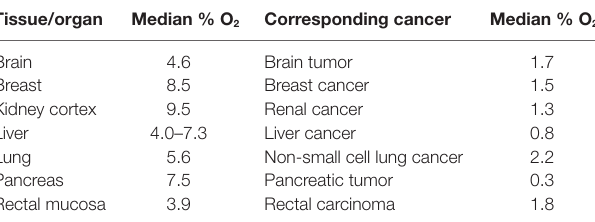
TAble 1 | The median percentage of O 2 in some organs and in their corresponding tumors.